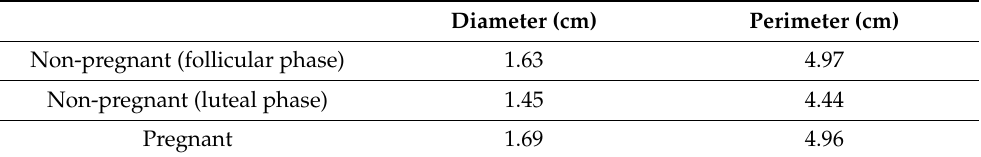
Table 2. Average measurements of the agouti’s ( D. fuliginosa ) vagina, according to Mayor et al. [25]. Diameter (cm) Perimeter (cm) Non-pregnant (follicular